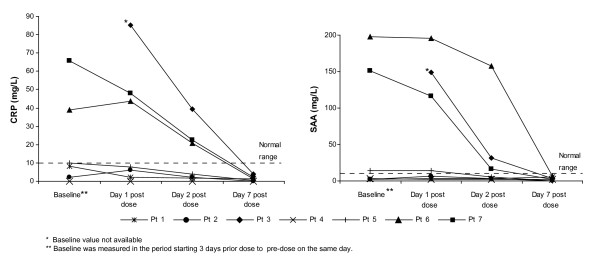
Reduction in inflammatory markers in response to a single dose of canakinumab.